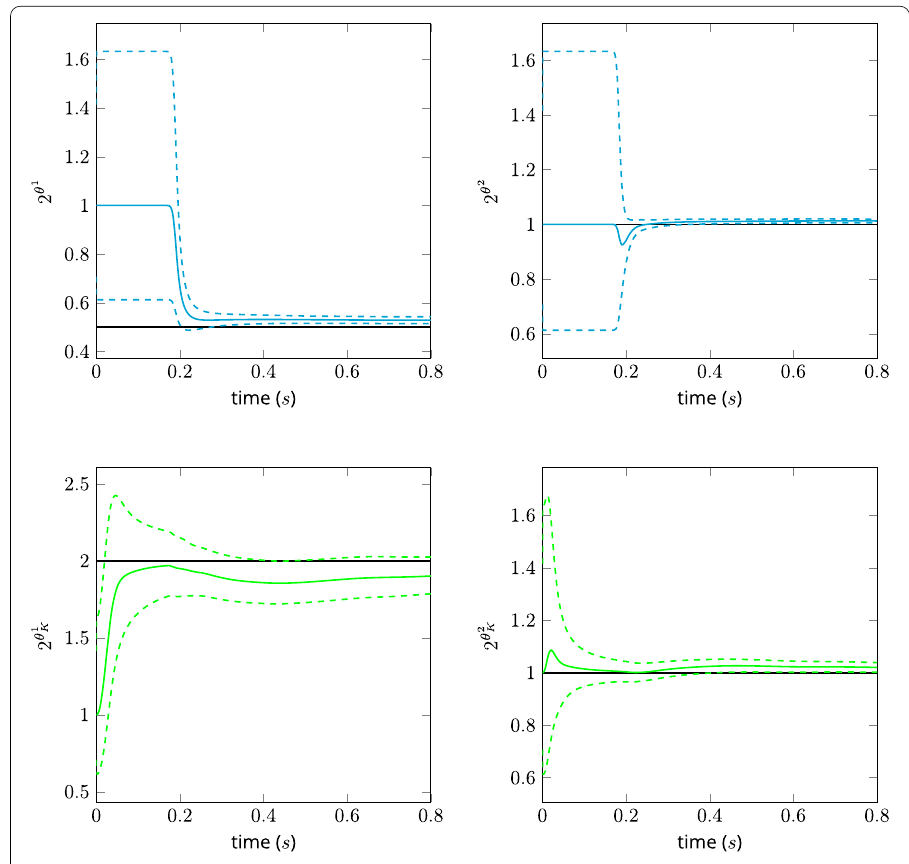
Fig. 12 Estimation of active (top) and passive (bottom) parameters using (3D) tag